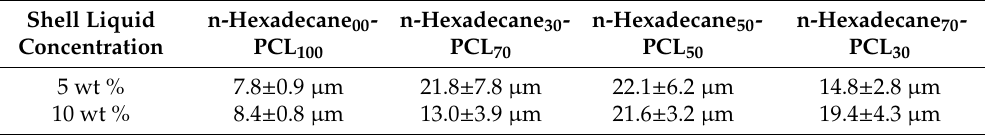
Table 2. The mean diameter and size distribution of obtained